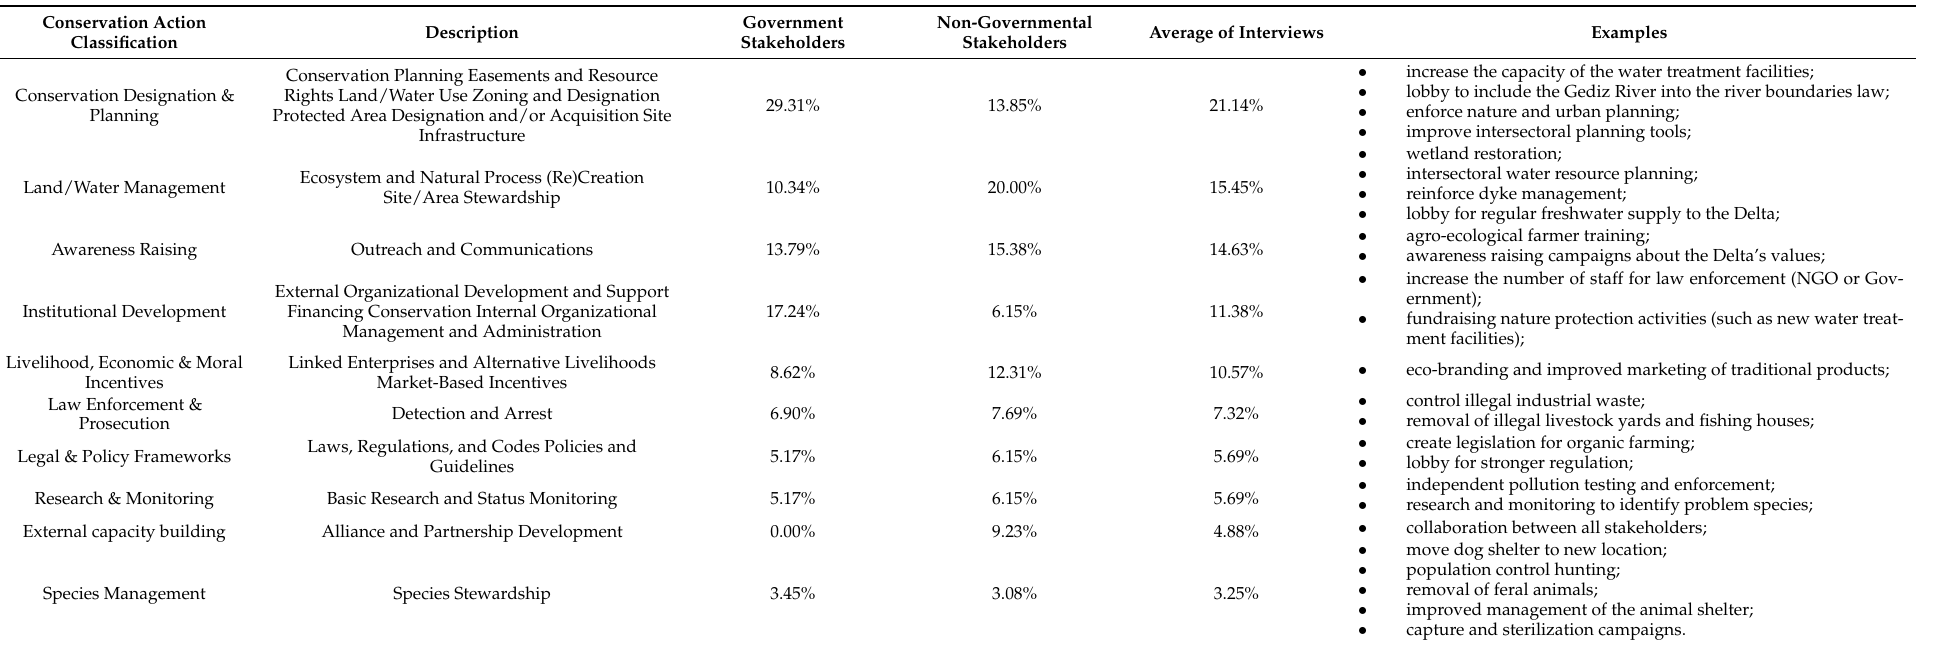
Table 2. Suggested conservation actions for the Gediz Delta and their frequency as identified by stakeholders (classified according to the Conservation Standards